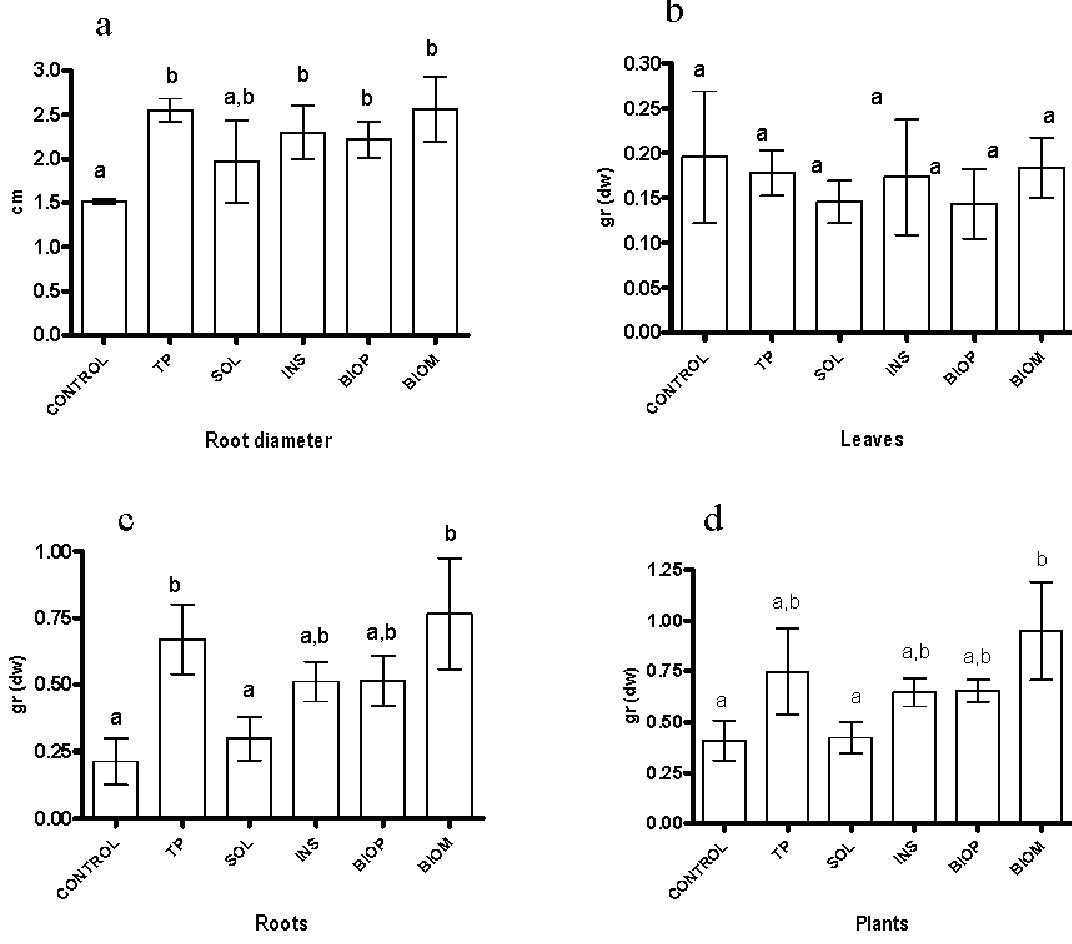
Figure 3. Plant performance indexes vs. treatments ( a ) root diameter; ( b ) leaves dry weight; ( c ) roots dry weight; ( d ) whole plant dry weight. Values are the mean of three replications with standard deviation. Letters in columns indicate statistical significance—samples not sharing a letter differ significantly at p < 0.05.